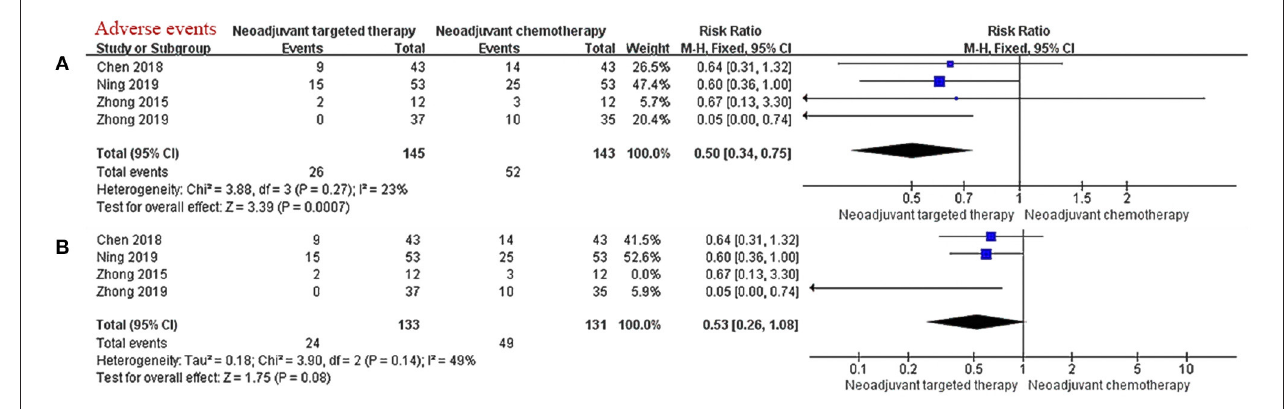
Random sequence generation